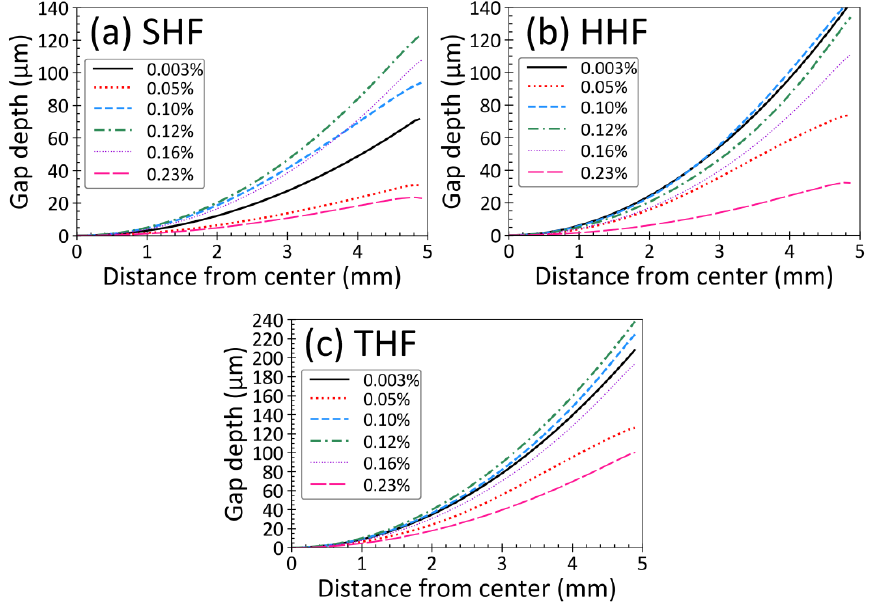
Figure 8. Gap depth profiles for six steel grades investigated and different heat fluxes at time when bottom surface temperature is 300 °C: ( a ) SHF; ( b ) HHF; and ( c ) THF. The low-carbon steels (0.05%C) and high-carbon steels, 0.23%C, consistently have shallow gaps. This trend of gap depth change with carbon content agrees with the experimental measurements [11,18].